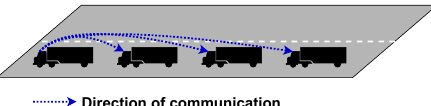
Figure 4. Centralised topology of platooning communications.